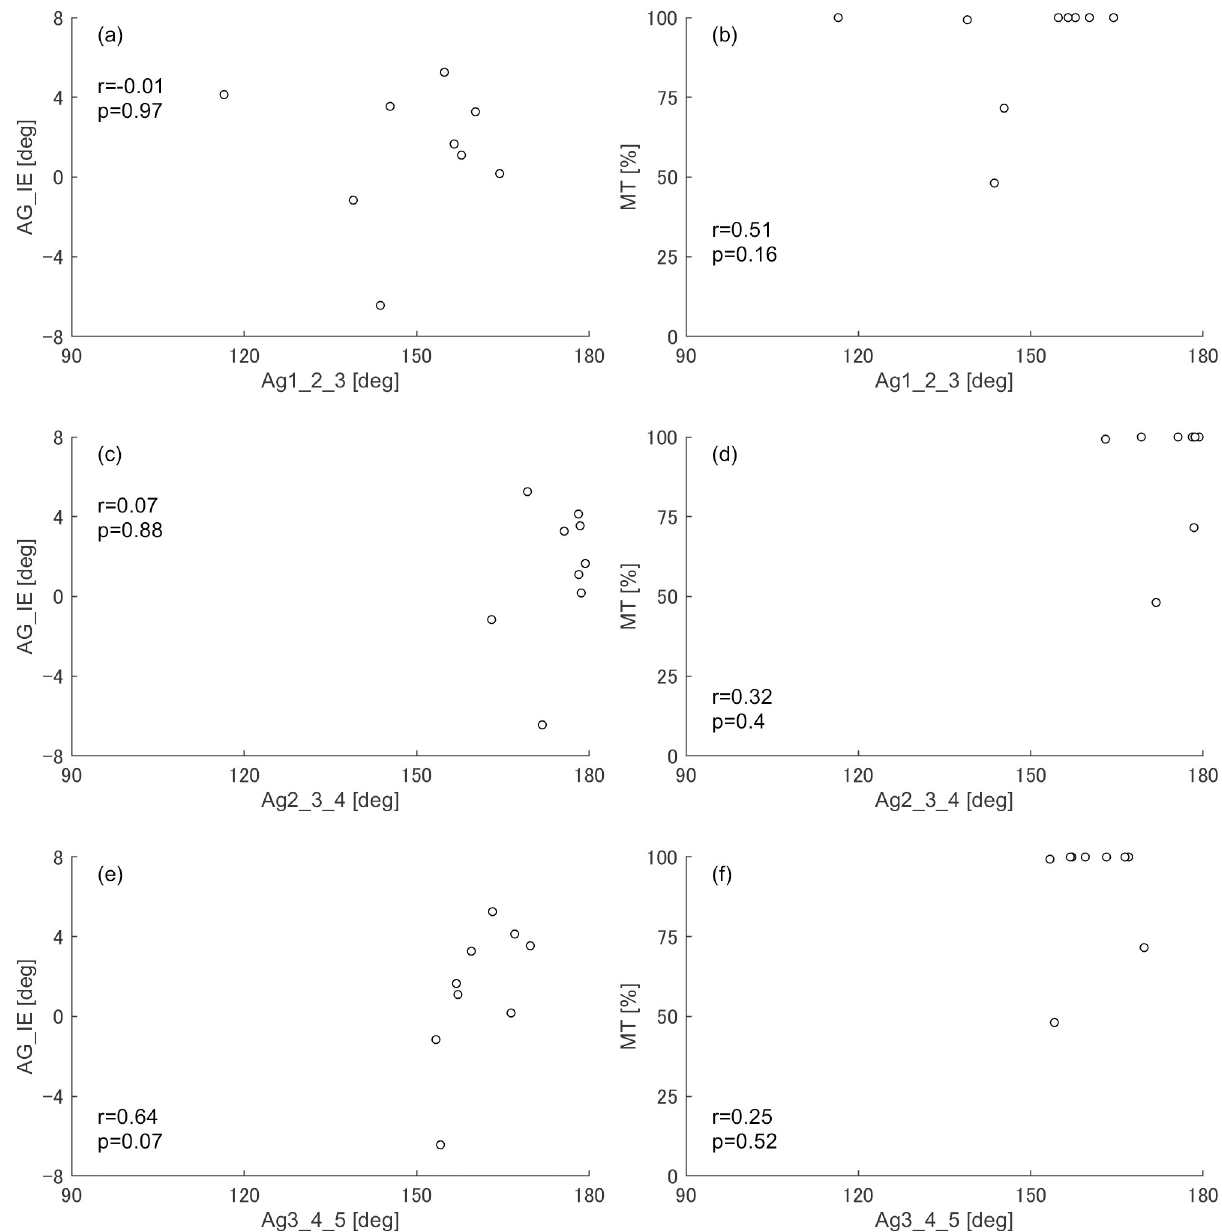
Fig 4. Correlation between angles representing metatarsal alignment and relevant variables when standing on the dominant leg. AG_IE and MT indicate the mean foot inversion ( − )/eversion (+) angle and the % duration when the centre of pressure positions was located medial to the second metatarsal head, respectively, against the total duration of the balancing phase. Graphs with black circle plots indicate significant correlations with the angle representing metatarsal alignment and variables after considering effects of the multiple testing. (a) the foot inversion/eversion angle does not correlate with the angle 1-2-3; (b)% duration to load medially does not correlate with the angle 1-2-3; (c) the foot inversion/eversion angle does not correlate with the angle 2-3-4; (d) % duration to load medially does not correlate with the angle 2-3-4; (e) the foot inversion/eversion angle does not correlate with the angle 3-4-5; (f) % duration to load medially does not correlate with the angle